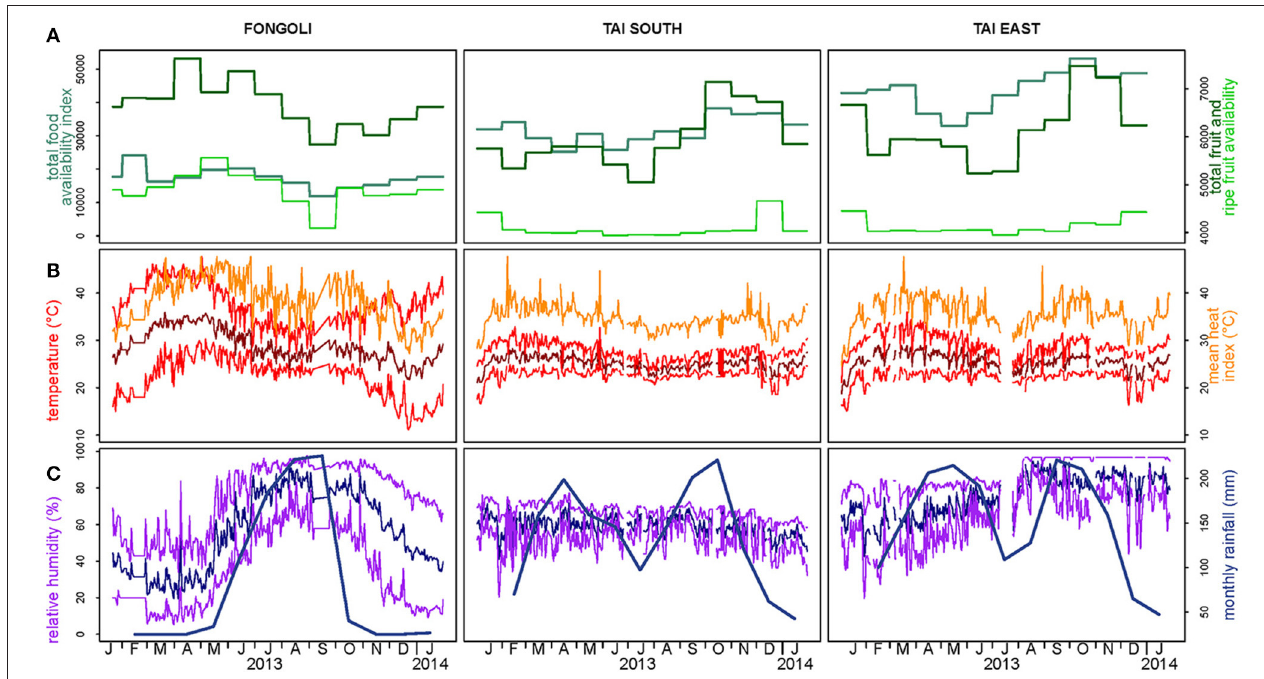
FIGURE 2 | Variation during one annual cycle (2013–2014) of environmental variables for three chimpanzee communities. These include (A) total (dark green, bold), total fruit (green), and ripe fruit availability (light green) indices, (B) daily temperature maxima, means, and minima (red) and daily mean heat index (orange), and (C) daily relative humidity maxima, means, and minima (purple) and rainfall per month (blue).